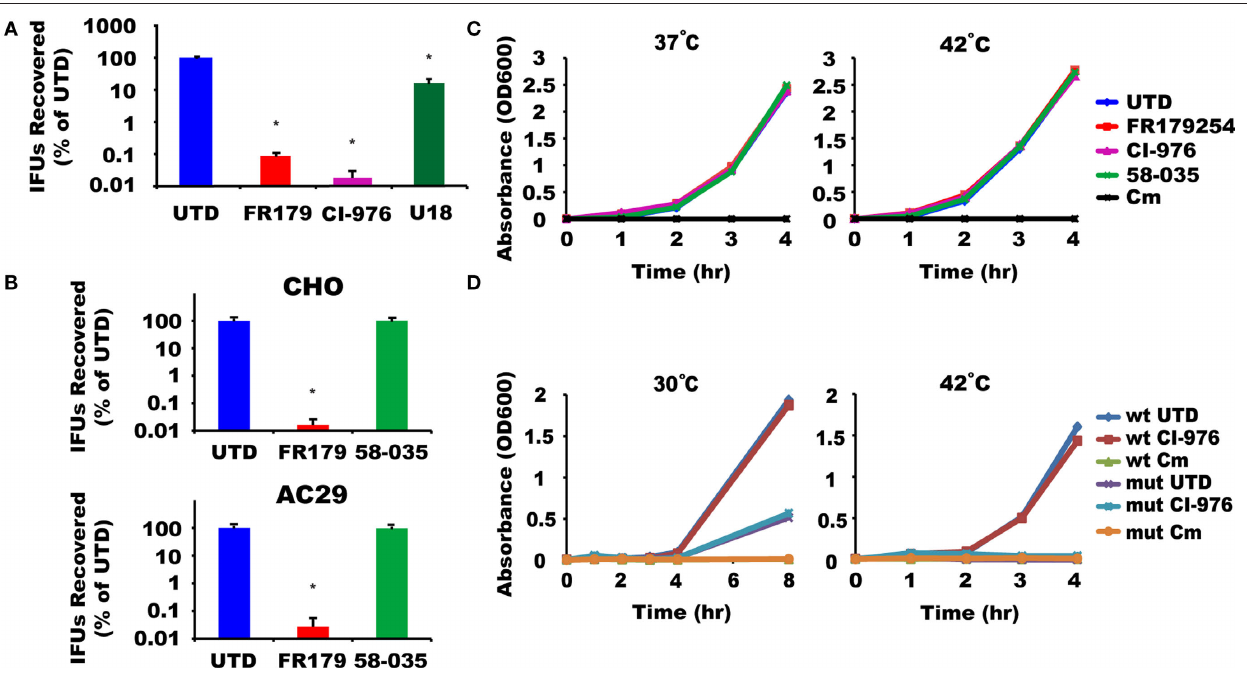
Figure 1 | Fr179254 blocks chlamydial growth by targeting host cell LPAT and not ACAT or bacterial enzymes. (A) FR179254 (FR179) and CI-976 block chlamydial growth. Effect of indicated treatments on recovery of inclusion forming units (IFUs), a measure for infectious EBs. (B) Chlamydiae grow in the absence of ACAT activity. CHO or AC29 cells, a CHO cell mutant which lacks ACAT activity, were infected with Chlamydia trachomatis serovar L2 and treated with or without FR179254 or the ACAT inhibitor 58-035 and recovery of infectious